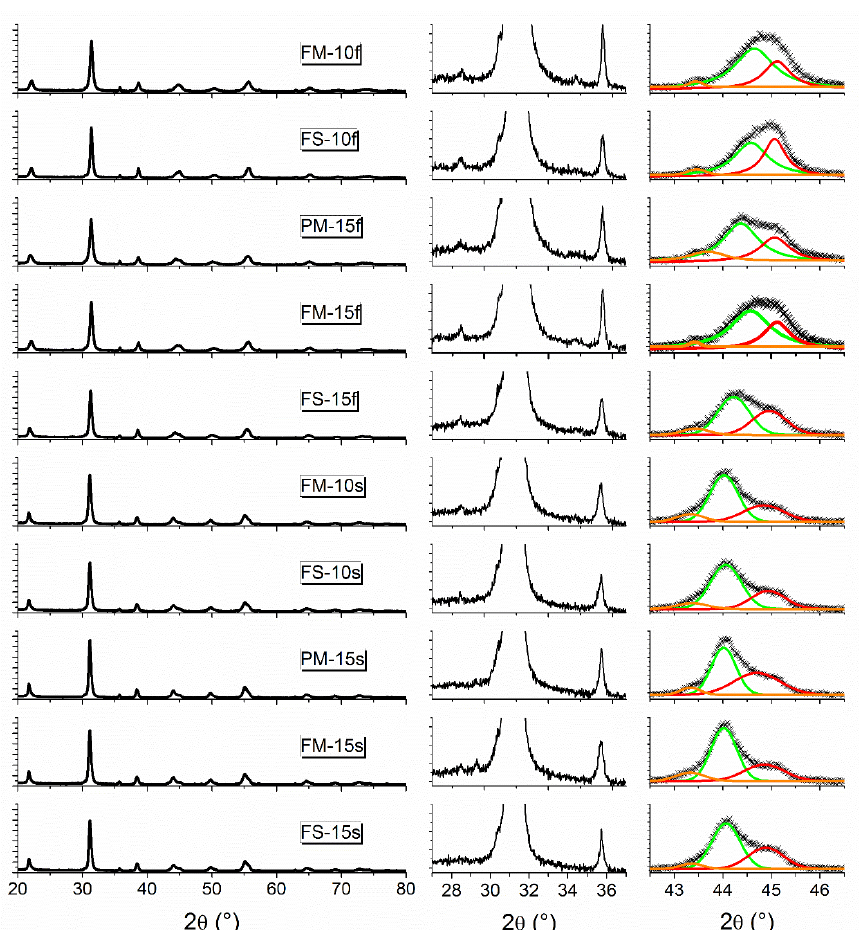
Figure 1. X‐ray diffraction (XRD) patterns of the sintered composites. In all abscissae and ordinates 2θ values in degrees and cps are shown. In the first column, the entire diffractogram is shown (cps = 0–13000). The second column details the region with the highest peaks attributed to ZrO 2 (2θ ≈ 28°), PZT (2θ ≈ 31°) and CFO (2θ ≈ 35.5°) (cps = 0–1100). In the third column, (0 0 2) and (2 0 0) diffraction peaks of the PZT tetragonal phase are fitted with solid orange and red lines, (2 0 0) peak of the PZT rhombohedral phase is fitted with a green line (cps = 0–1800). (For interpretation of the references to color in this figure legend, the reader is referred to the web version of this article).